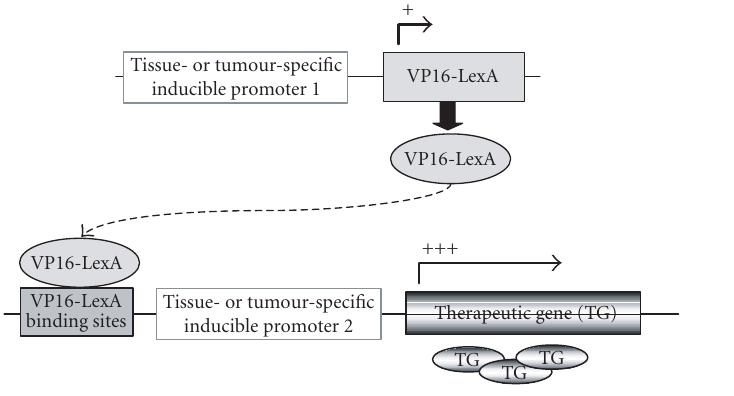
Figure 2. Schematic outline of a positive feedback loop utilising VP16/LexA to enhance weak promoters. Transcription is initiated by the cell-type-specific promoter in target cells which leads to expression of the VP16/LexA fusion protein. The VP16/LexA protein then interacts with the LexA binding sites upstream of a possible second cell-type-specific promoter leading to transactivation and thus enhancement of transcription. Alternatively, the VP16/LexA fusion protein could be expressed along with the transgene expressed via an IRES. Adapted from Nettelbeck et al [179].